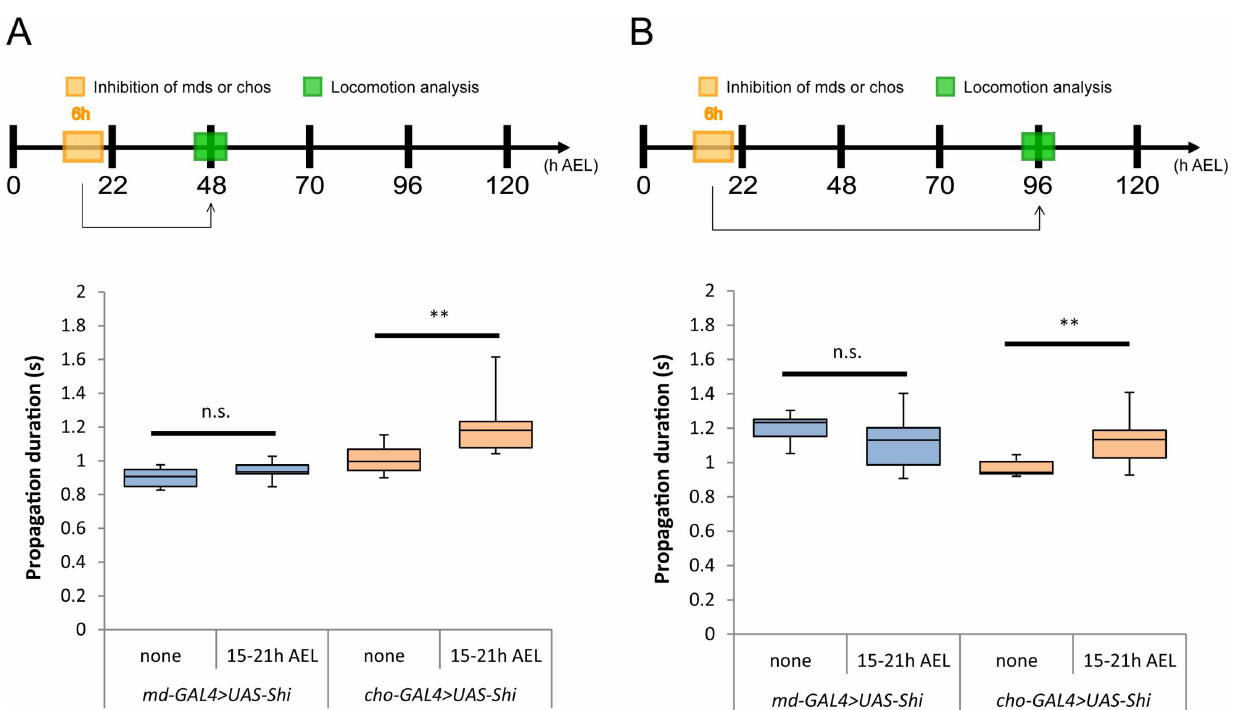
Figure 2. Inhibition of chos at late embryonic stage affects peristalsis in mature larvae. Effects of inhibiting the activity of multidendritic neurons (md neurons, mds) or chordotonal organs (chos) during 15–21 h AEL. Inhibition of chos (orange boxes) but not md neurons (blue boxes) led to propagation defects in the second (A) and third (B) instar. Box plots indicate the median value (horizontal line inside the box), 25–75% quartiles (box), and the data range (whiskers). Statistical significance was determined by Mann-Whitney U test (**P , 0.01; n.s., not significant). For all conditions, n=10. RT, restrictive temperature. 109(2)80-GAL4 and iav-GAL4 were used as md neurons and chos drivers, respectively.